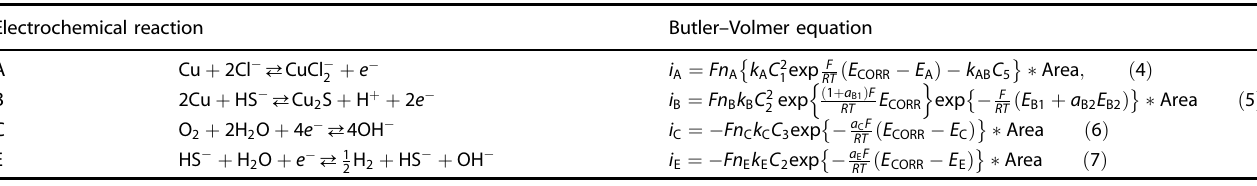
All variables and constants are de fi ned in Tables 3 and 4, respectively. Area means element area of copper surface in speci fi c